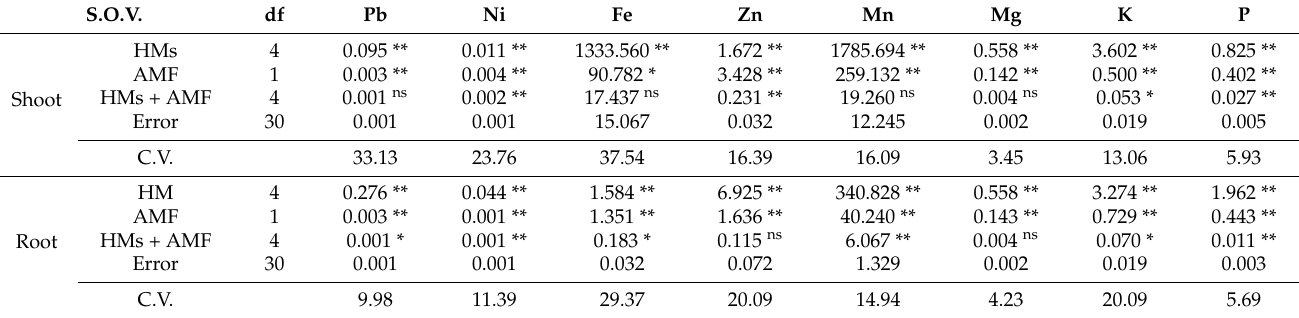
Table 4. ANOVA for the effects of arbuscular mycorrhiza fungi (AMF) inoculation × Pb and Ni stress on macro-and micronutrient contents in lavender plants.